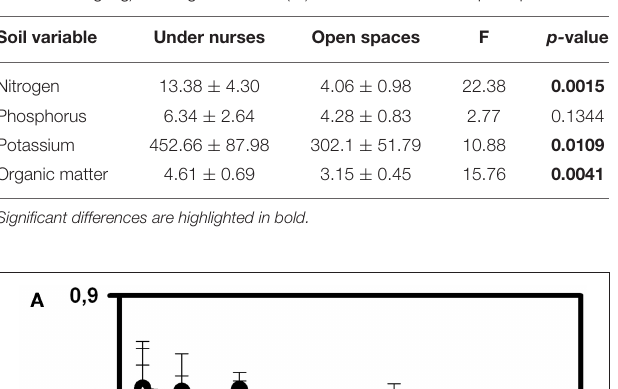
conditions presented significantly lower values ( Figure 3A ). On